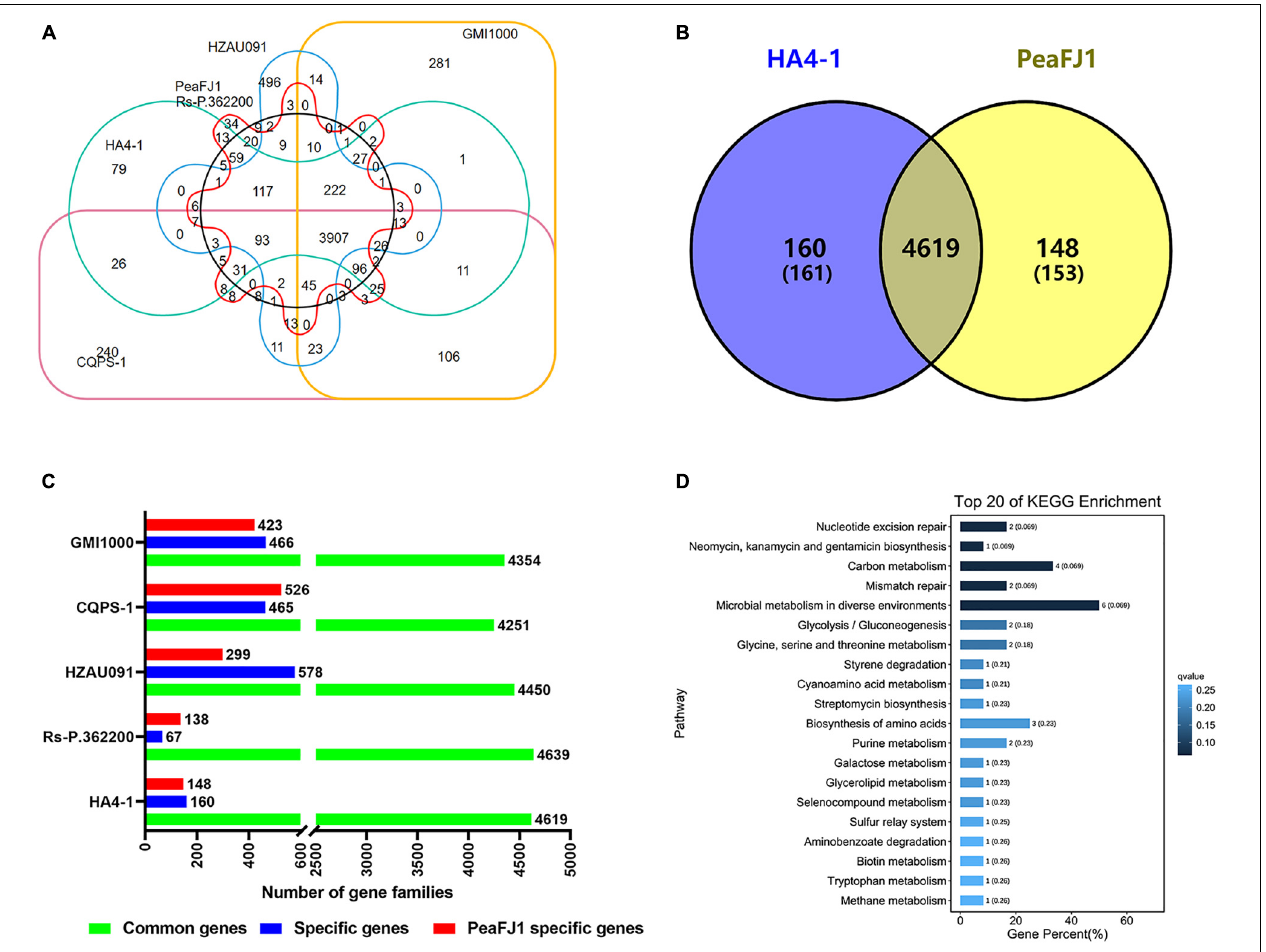
FIGURE 5 | Comparison of orthologs of strain PeaFJ1 with other R. solanacearum strains. (A) A big Venn diagram of orthologs for PeaFJ1, HA4-1, Rs-P.362200, HZAU091, GMI1000, and CQPS-1. (B) Statistical analysis of common/specific orthologs between PeaFJ1 and the other five strains. The x -axis indicates the number of gene families; the y -axis means the different R. solanacearum strains. Green bar, blue bar, and red bar mean common gene families, specific gene families, and PeaFJ1- specific gene families when PeaFJ1 is compared with the other five strains, respectively. (C) A Venn diagram of the common/specific genes between PeaFJ1 and HA4-1. (D) Top 20 enriched KEGG pathways of strain-specific genes in PeaFJ1 whole genome. The q -value results from the p -value via multi-test correction. The ranges of q -value are from 0 to 1, and a higher enrichment is achieved when the q -value reaches to